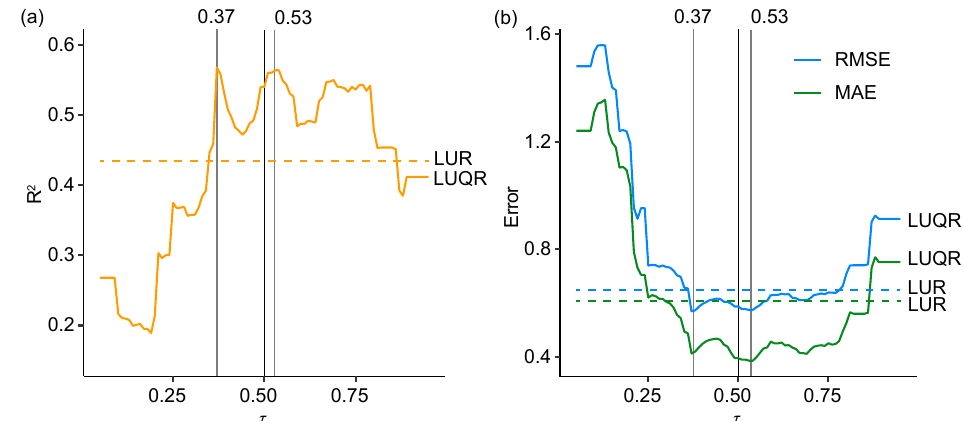
Figure 4. The leave-one-out cross-validation (LOOCV) of land use quantile regression (LUQR) models of PM 2.5 with different values of quantile parameter τ . ( a ) Comparison of R 2 of LUR (dashed orange line) and LUQR (orange line); ( b ) Comparison of RMSE (blue) and MAE (green) of LUR (dash lines) and LUQR